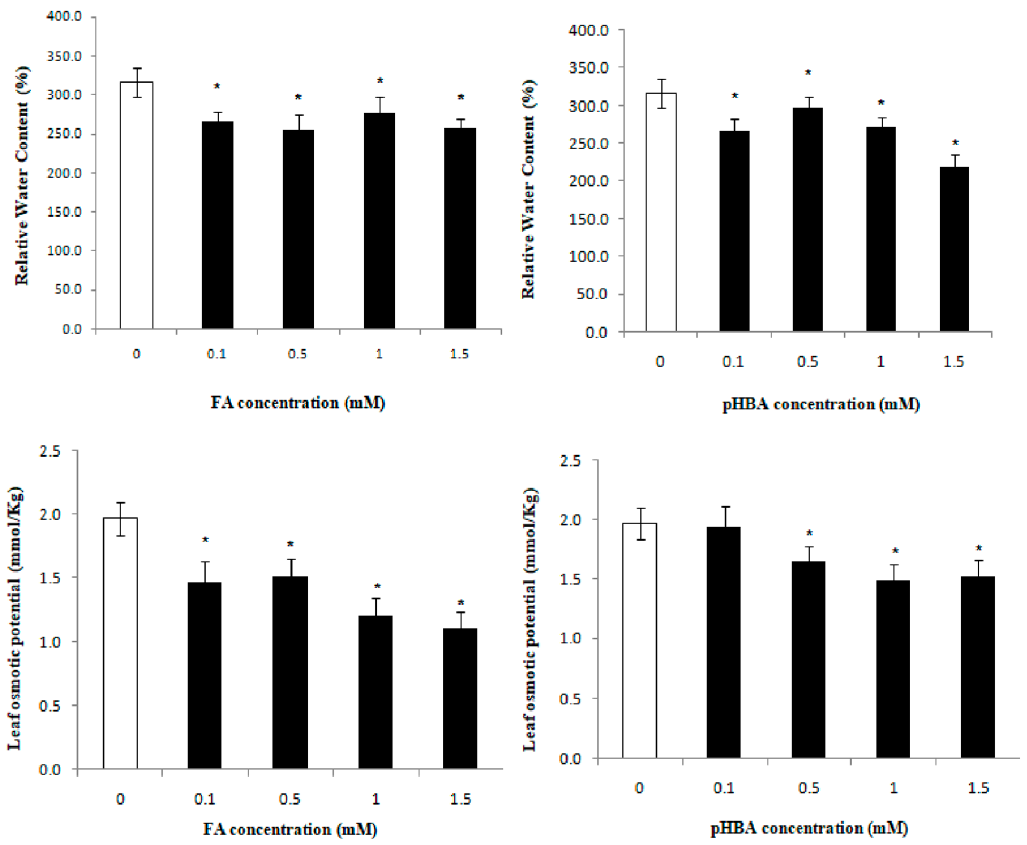
Figure 2. Leaf relative water content (%) and leaf osmotic potential (mmol/Kg) in leaves of Rumex acetosa L. one week after exposure to four concentrations (0.1, 0.5, 1.0, and 1.5 mM) of ferulic acid (FA) and p -hydroxybenzoic acid (pHBA) and control. Every column in each graph represents the mean ( ± S.E.) of three replicates. * Asterisks indicate significant differences at p ≤ 0.05 with respect to control.